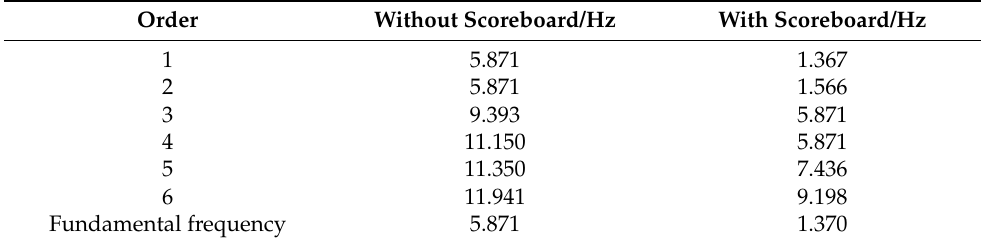
( b ) Figure 11. Numerical model: ( a ) Without center-hung scoreboard; ( b ) With center-hung scoreboard.